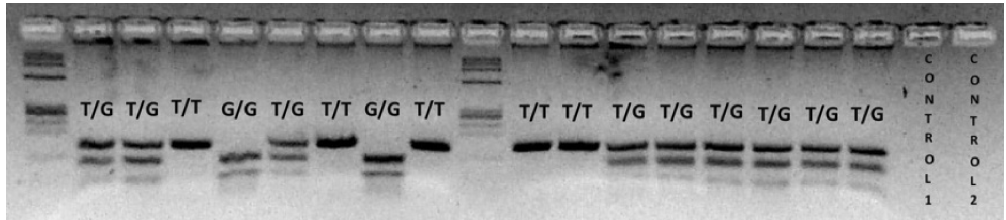
Figure 1. PCR-RFLP to determine MDM 2 SNP309 polymorphism. MDM 2 SNP309 T allele is not cleaved by MspA1I endonuclease and generates a single fragment of 155 bp. The MDM 2 SNP309 G allele is cleaved by MspA1I and generates two small fragments of 101 and 54 bp. The MDM 2 SNP309 heterozygote displays three fragments of 155, 101 and 54 bp.